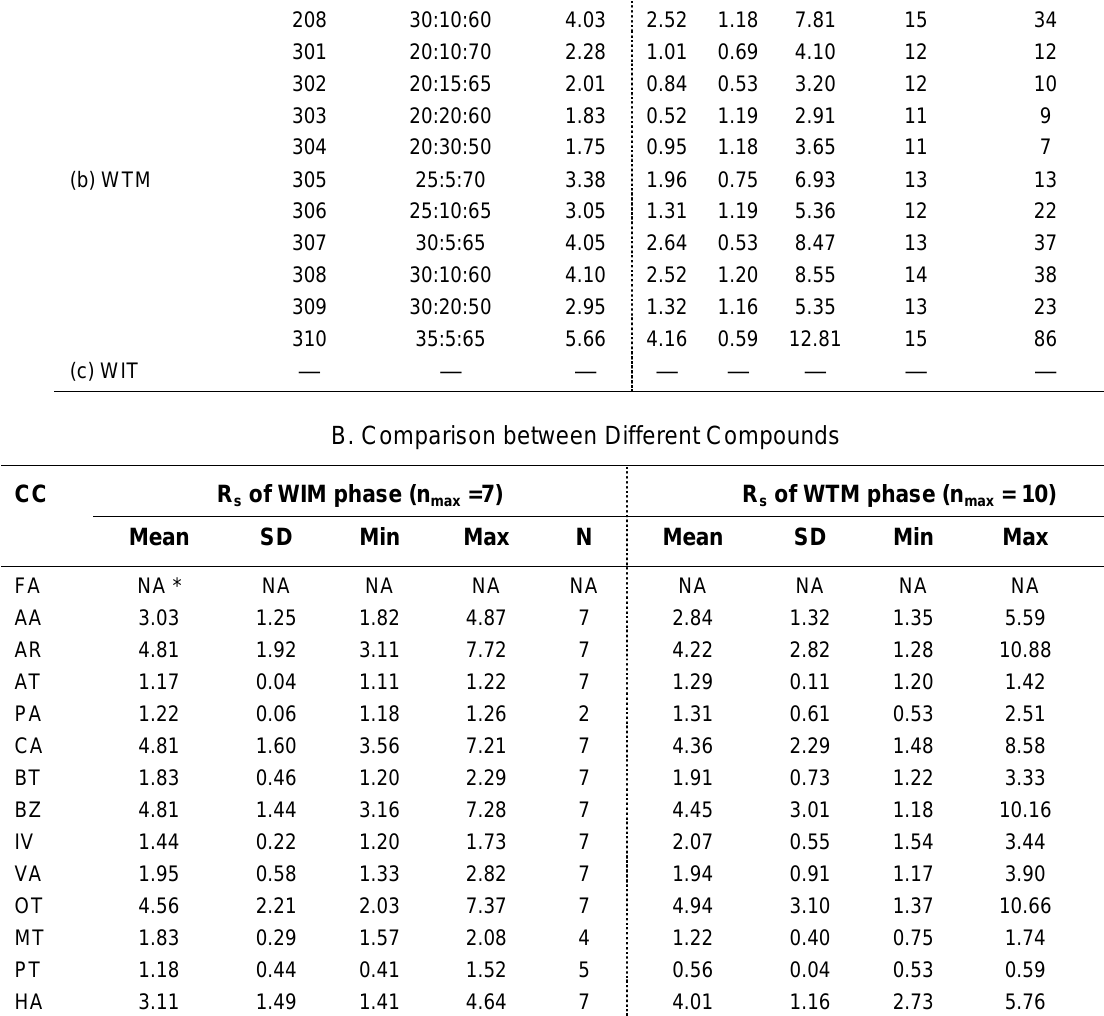
) Values between Different s